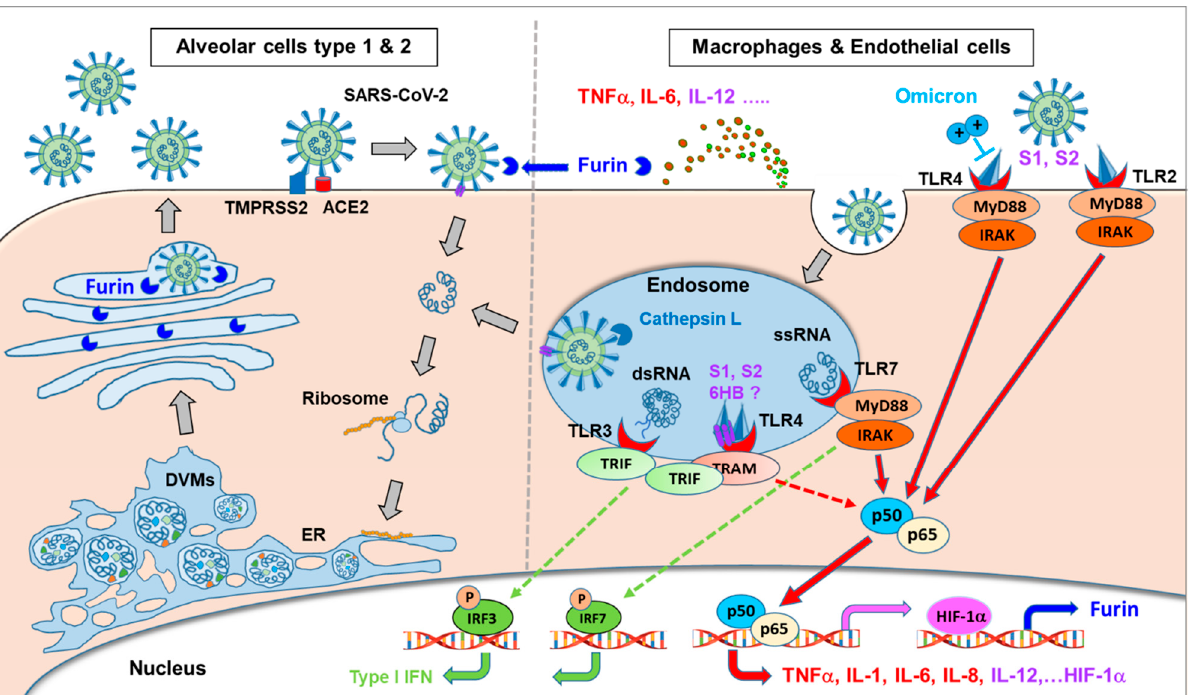
Figure 1. SARS-CoV-2 binds via the spike protein to ACE2, followed by fusion with the host cell membrane. Viral RNA transcription and translation of viral proteins occur in double-membrane vesicles (DMVs). The newly assembled virus particles leave the cells via the Golgi apparatus where the spike protein undergoes proteolytic cleavage by furin. This process occurs preferably in virus- producing cells with a high TMPRSS2 expression, such as alveolar cells ( left side ). Alternatively, the virus can be taken up into endosomes, predominantly in cathepsin L-rich cells, such as innate immune cells and endothelial cells ( right side ). Several components of the SARS-CoV-2 virus act as PAMPs by activating various TLRs, resulting in massive activation of the NF-kB (p50/p65) pathway. Different cells differ regarding their expression of TLRs, with high levels of TLR4 and TLR2 expressed by macrophages and endothelial cells, but low levels by alveolar lung cells. Adapted from [1]. The second article discusses how the outcome of SARS-CoV-2 infection is dependent on the balance between induced antiviral immunity and tissue damage. Surface (TLR2 and 4) and intracellular (TRL3, 7/8, and 9) factors are involved in the recognition of SARS-CoV-2 infection by the immune system. Adaptors such as MyD88 and TRIF are recruited by TLRs to initiate the signaling pathways (Figure